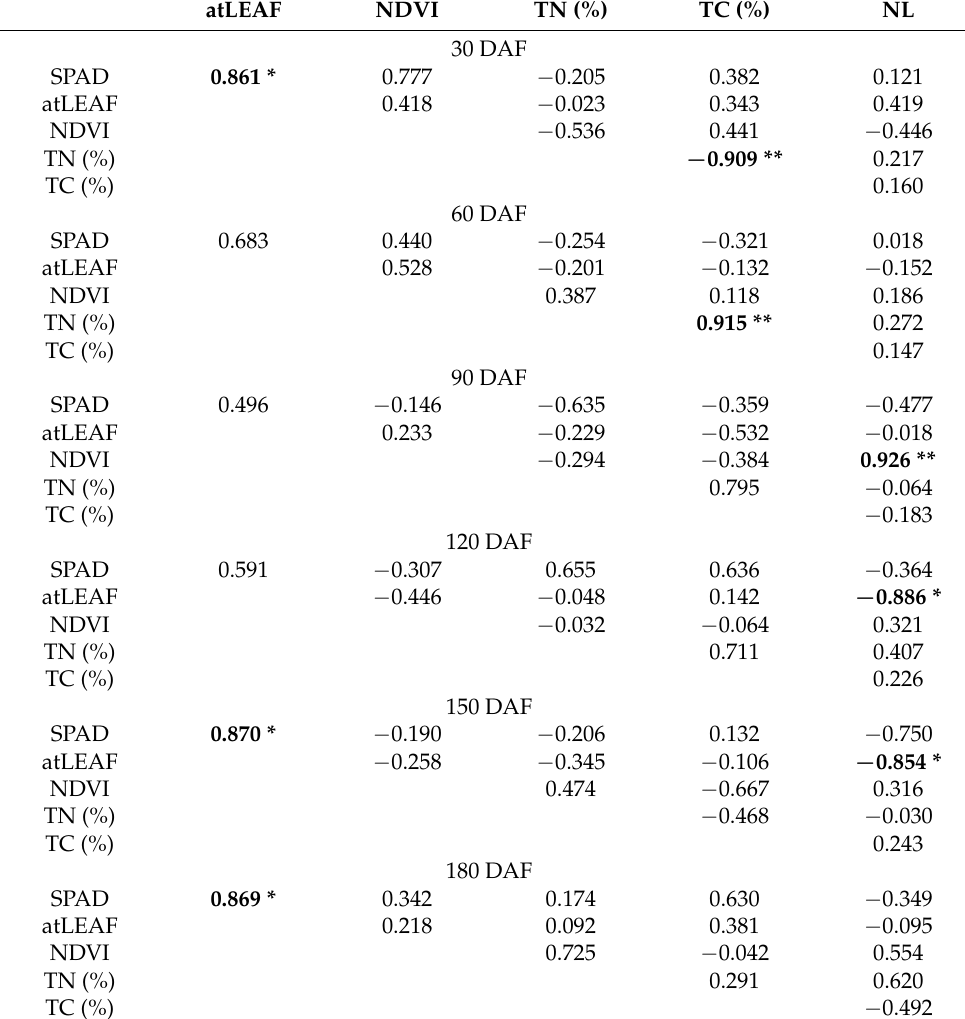
Table 7. Correlation coefficient (r) for chlorophyll content (indicated by SPAD unit and atLEAF unit), normalized difference vegetation index (NDVI), number of leaves (NL), and total nitrogen (TN) and total carbon (TC) of leaf samples in cocoa of 0–6 months. atLEAF NDVI TN (%) TC